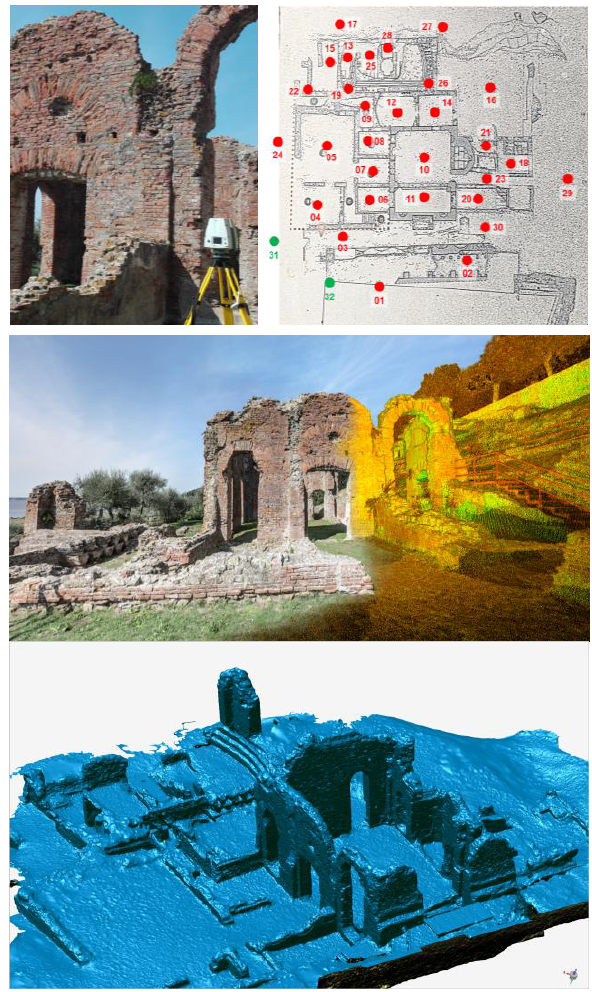
Figure 3. Laser scanning survey of the thermal area of Massaciuccoli archaeological park. From top to bottom pictures: the instrument, model ScanStation C10 by Leica Geosystems during scanning activities (top left) and planning of the scanning positions (top right); 3D point cloud with intensity false colors (central right) and photo-realistic appearance (central left); 3D model obtained by meshing process.